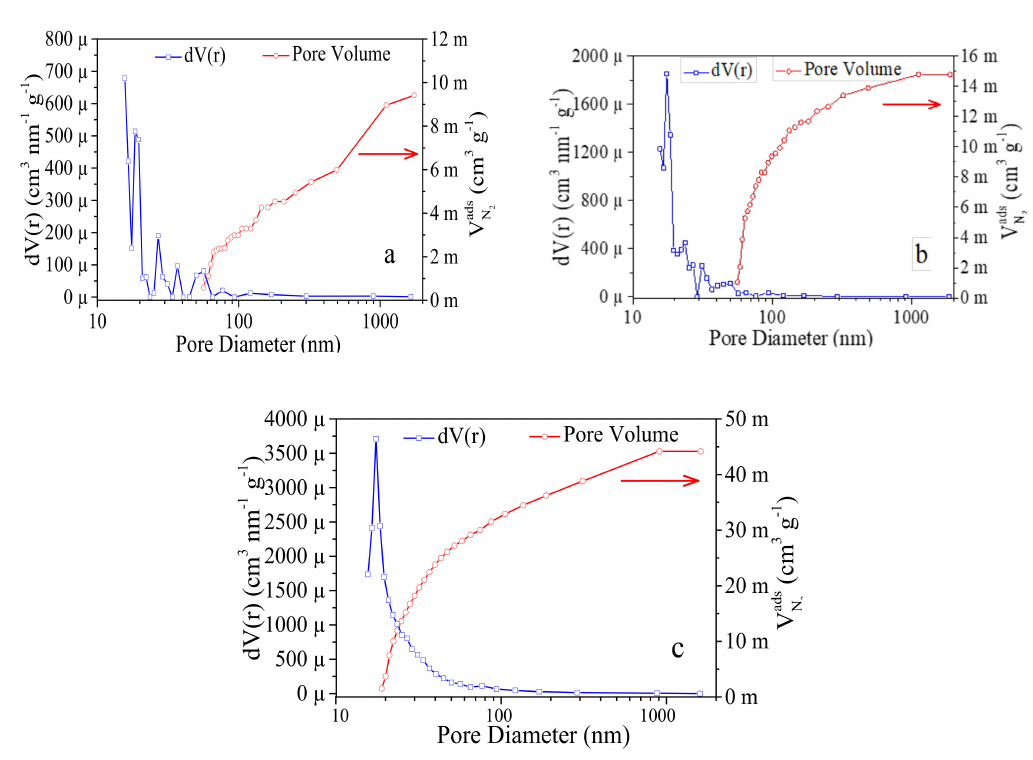
Figure 5. Pore size distribution of: ( a ) 1200 ◦ C (C-5); ( b ) 1300 ◦ C (C-10); ( c ) 1400 ◦ C (C-15) samples.